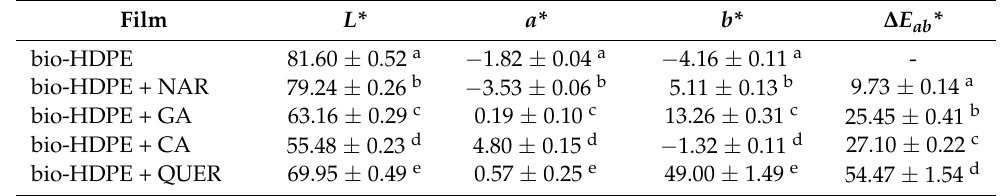
Table 2. Color parameters ( L *, a *, b *) and difference ( ∆ E ab *) of the thermo-compressed bio-based high-density polyethylene (bio-HDPE) films containing naringin (NAR), gallic acid (GA), caffeic acid (CA), and quercetin